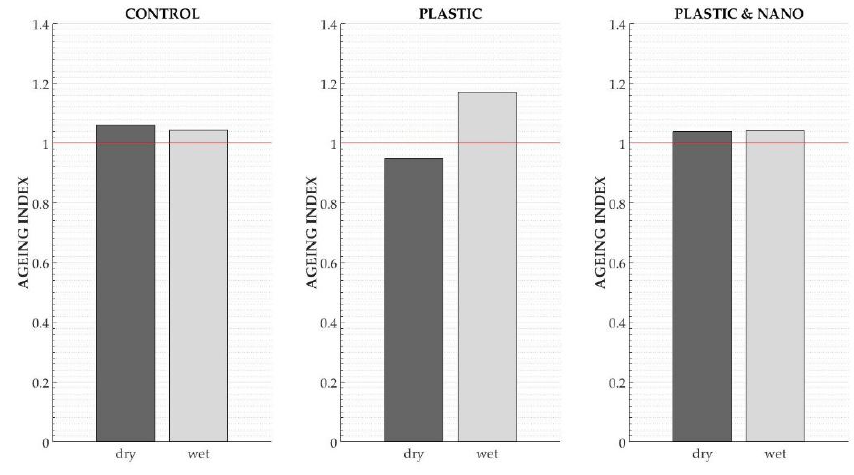
Figure 8. Values of ageing index for the tested mixtures and dry/wet specimens.